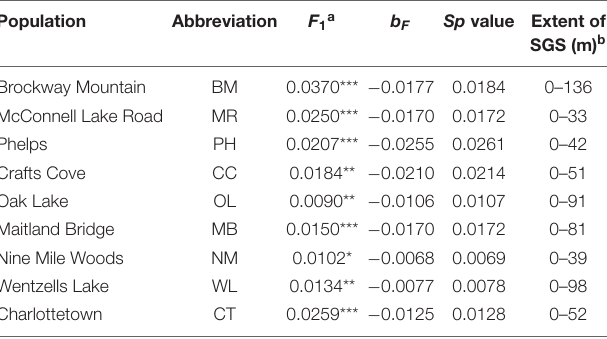
TABLE 3 | Kinship coefficients of the first distance class ( F 1 ), their regression slope on natural log distance ( b F ), resulting Sp value, and the extent of SGS within northern red oak